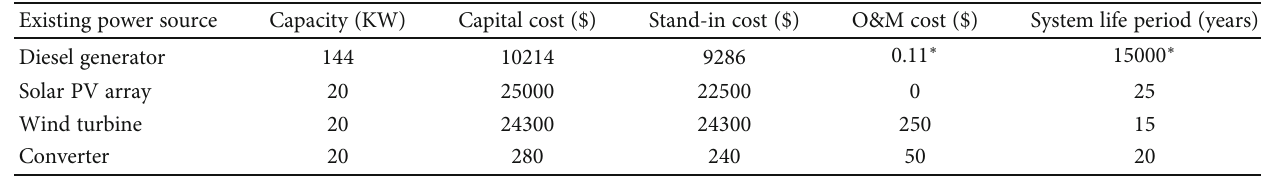
Table 1: Economic data for simulation.